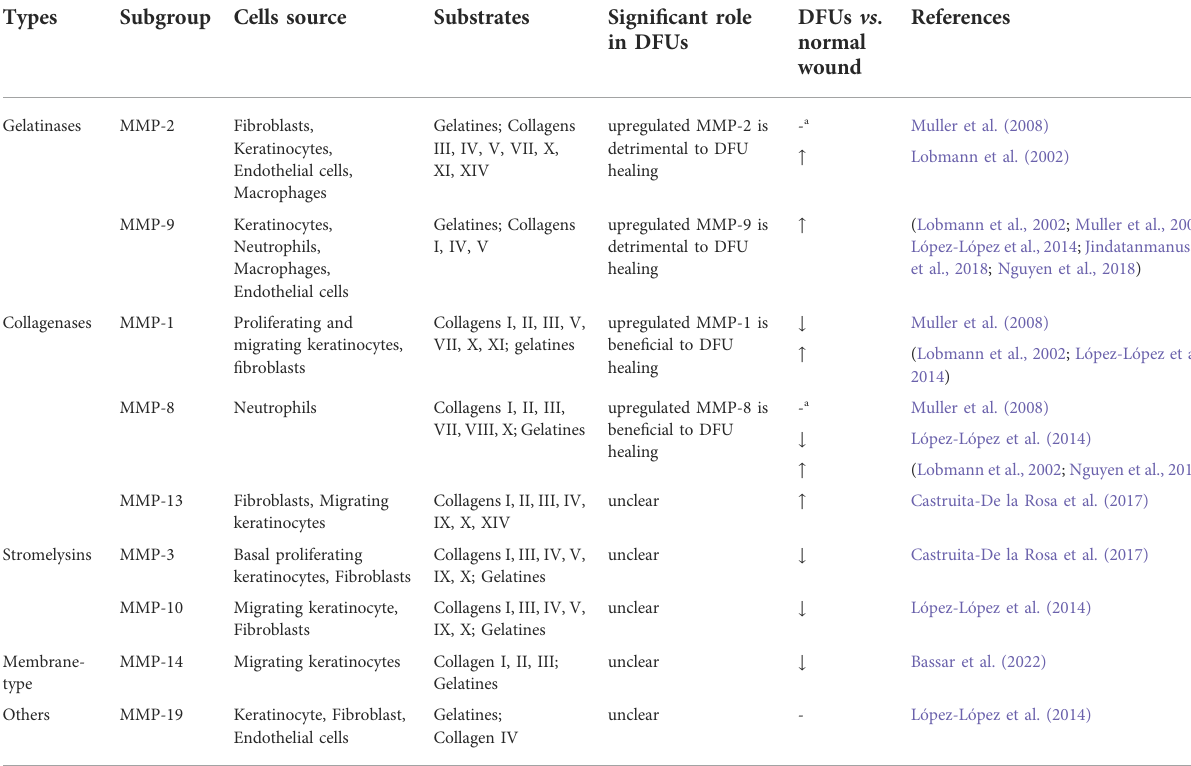
TABLE 1 The expression level of MMPs in